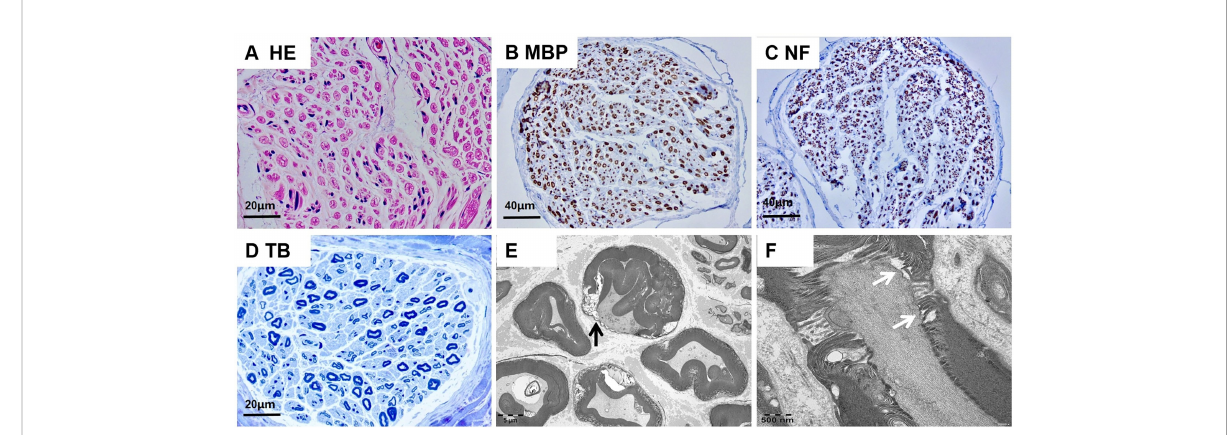
FIGURE 2 Neuropathologic fi ndings of sural nerve biopsy. (A-D) Optical microscopy showed no presentation of demyelinated fi bers, in fi ltration of in fl ammatory cells, or onion bulb formation. (E) Transmission electron microscopy showed demyelination(black arrow), and no axonal degeration was observed. (F) Longitudinal ultrathin sections of the nodal region showed the enlargement of the space between the axon and the paranodal loops(white arrow). Scale bars = 20 µm (A, D) ; 40 µm (B, C) ; 5 µm (E) ; 500nm (F)